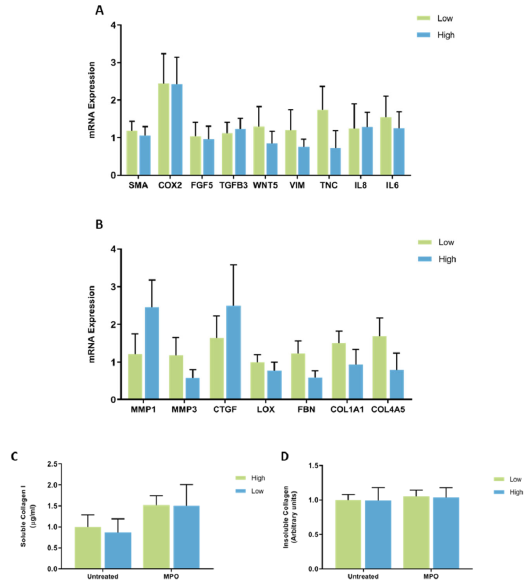
Figure 5. The effect of MPO on mRNA expression and collagen production in mammary fibrob- lasts isolated from women with high and low mammographic density. Messenger RNA expression of cancer-associated genes ( A ) and genes involved in extracellular matrix regulation and colla- gen production ( B ) measured by RT-PCR in human mammary fibroblasts from women with high ( n = 7) and low ( n = 9) mammographic density following treatment with 5 µ g/mL of MPO for 72 h. mRNA expression normalised to HPRT1 expression and presented as relative expression where the average for untreated control is 1. Collagen production was measured using collagen 1 ELISA ( C ) and insoluble collagen measured by sirius red staining ( D ). Data presented as mean + SEM with statistical analysis performed using a linear mixed-effects model Tukey’s post hoc